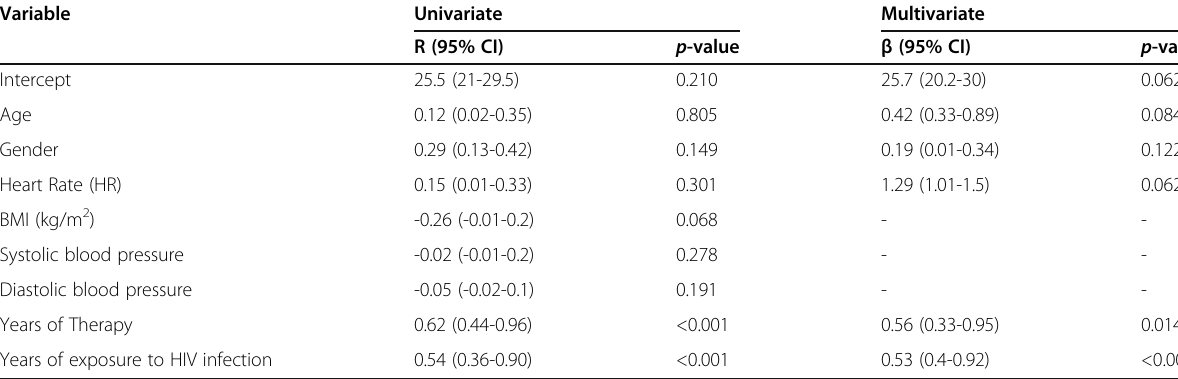
Table 3 (A) Univariate correlation analyses between ECV and characteristics of the HIV+ population. (B) Multivariate regression models for predictors of ECV expansion. Age, Heart Rate (HR), systolic and diastolic blood pressure, years of therapy and years of exposure to HIV infection were entered in this model. P-values as assessed by Pearson's correlation for normal distributions, Spearman ’ s correlation for non-normal distributions as well as β estimates and p-values from multivariate regression models are reported